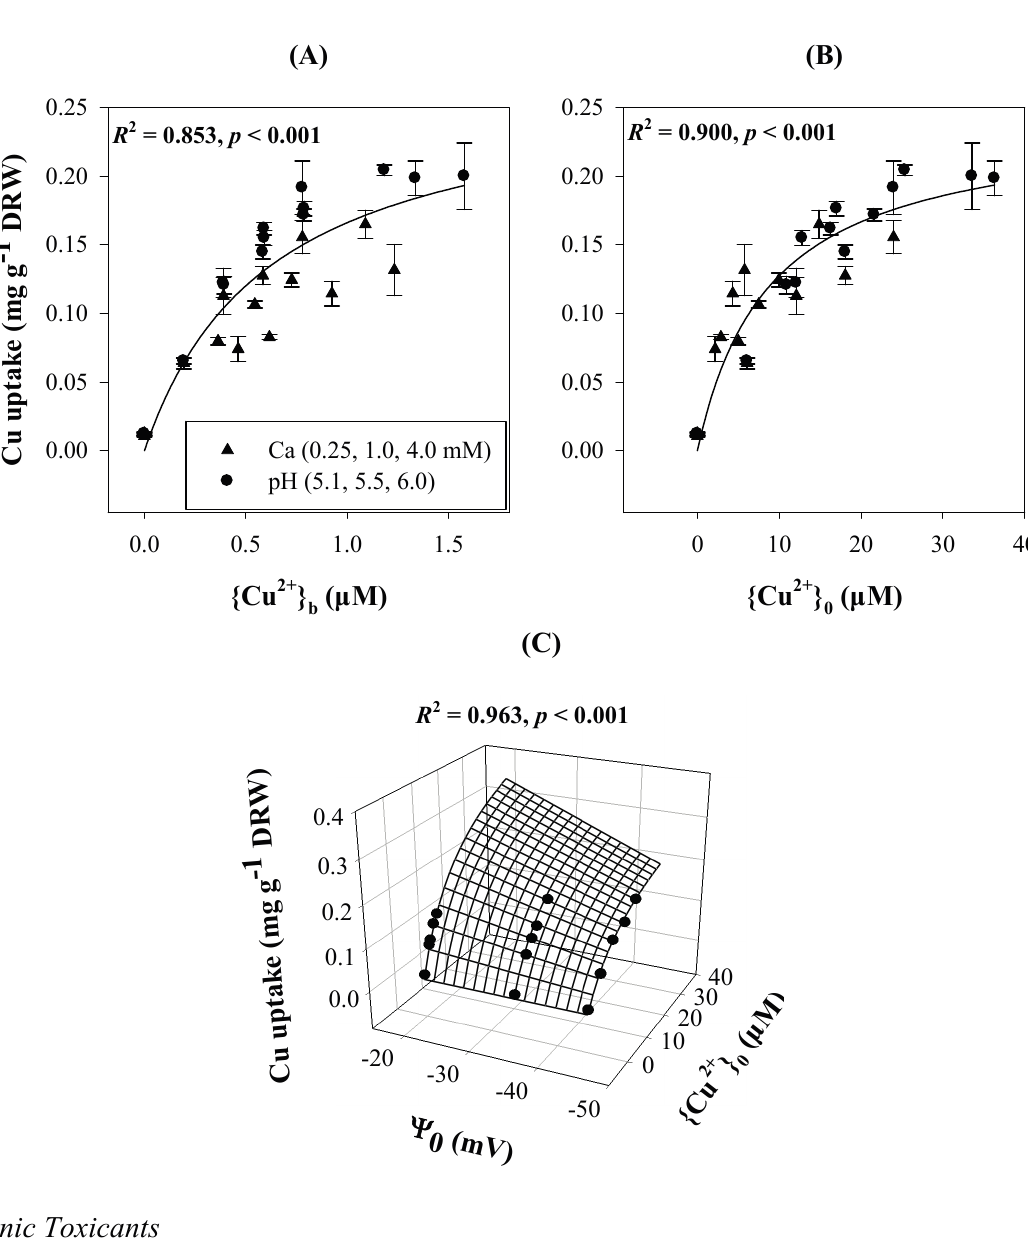
Figure 4. Metal accumulation in wheat seedling roots in response to Cu 2+ treatments under different values for pH (5.1, 5.5, and 6.0) and Ca concentration (0.25, 1.0, and 4.0 mM). Metal ion activities were expressed as ion activities in bulk-phase solutions ({Cu 2+ } b ) or activities at the PM surface ({Cu 2+ } 0 ). The Michaelis-Menten Equation Cu uptake = a {Cu 2+ } b /( K m + {Cu 2+ } b ) (Equation (12)) was used in ( A ); Cu uptake = a {Cu 2+ } 0 / ( K m + {Cu 2+ } 0 ) (Equation (13)) was used in ( B ); and Cu uptake = a (1 + b ψ 0 ){Cu 2+ } 0 / ( K m + {Cu 2+ } 0 ) (Equation (14)) was used in ( C ). Data were obtained from Wang et al.